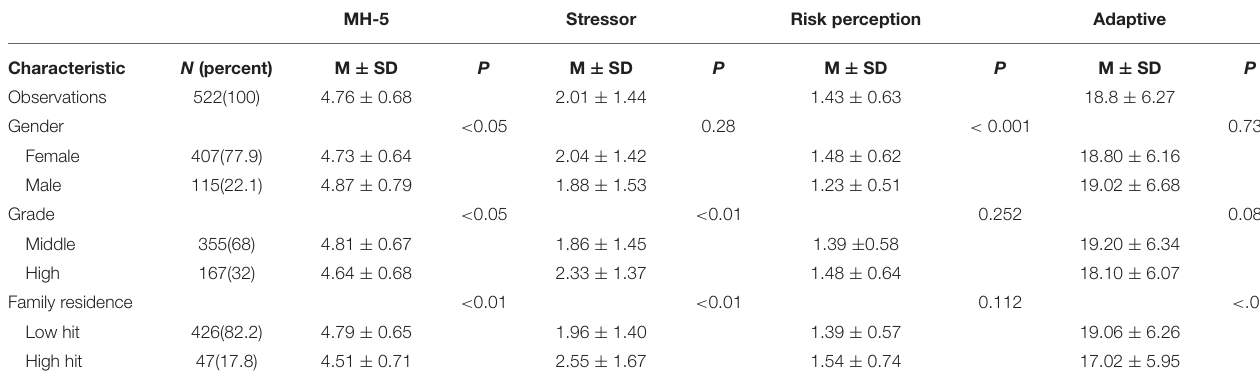
TABLE 1 | Demographic characteristics of the college students by psychological symptoms. Stressor Adaptive